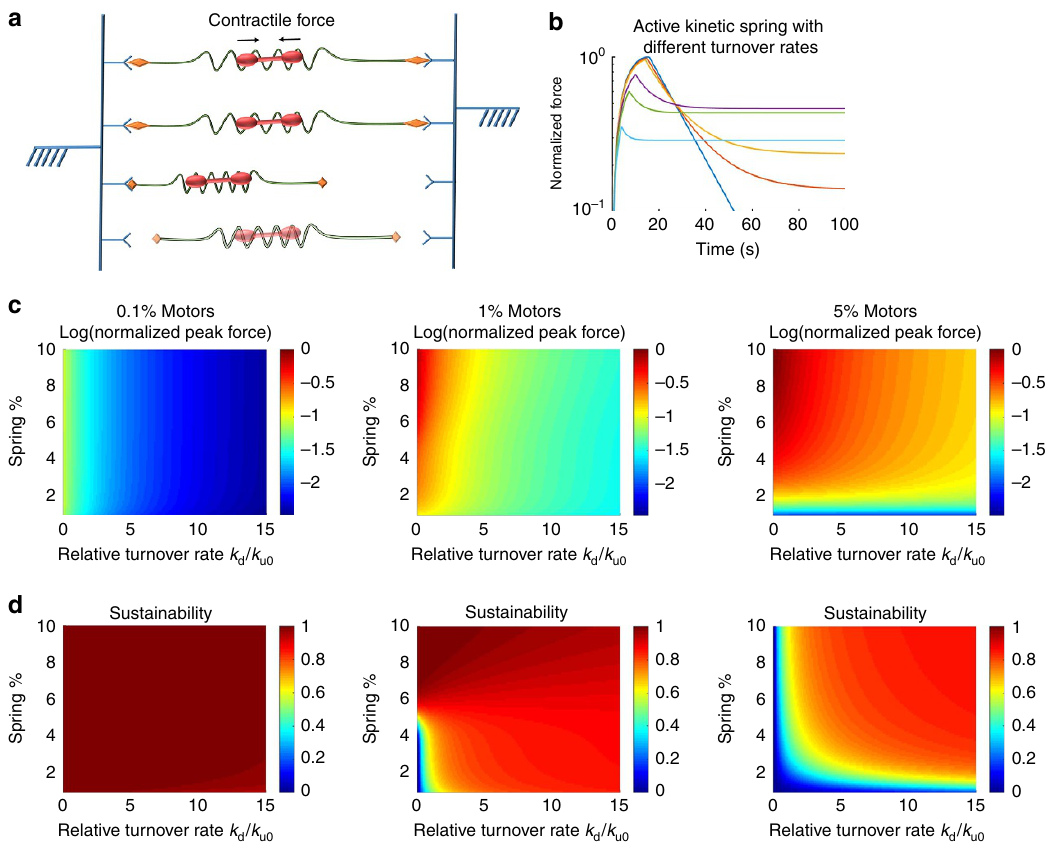
Figure 6 | Active kinetic spring model. ( a ) Schematic of the model—cytoskeletal springs (green) are connected to fixed boundaries (blue) by kinetic elements (orange diamonds and Yshapes) that can bind and unbind at force-dependent rates. Myosin motors (red) actively contract the springs internally, generating force. Components can also appear or disappear via turnover (transparency). The total force on the walls is the sum of the contractile forces from bound springs. ( b ) Force profiles based on the model for 25 m M actin and 0.1 ratio of springs (that is, ACP-actin spring constructs) and 0.05 ratio of motors to actin at different network turnover rates. Profiles with transient peaks and stable forces are both observed, as consistent with Brownian dynamics simulations. Curves from top to bottom (based on peak force) represent network turnover rates k d of 0, 0.1, 0.2, 1, 2 and 5 (cid:2) relative to k u0 . ( c ) Heat maps of the log of the normalized peak force for networks with different configurations. Forces are normalized to networks with 0.1:0.05 ratio between springs and motors and actin concentration of 25 m M. ( d ) Heat maps of S for corresponding configurations in c . The active kinetic spring model is able to qualitatively capture similar mechanical properties compared with Brownian dynamics